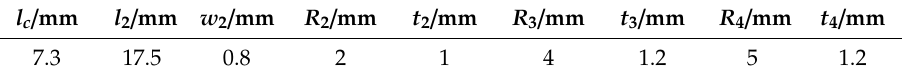
Table 3. The dimensions of the other parts.